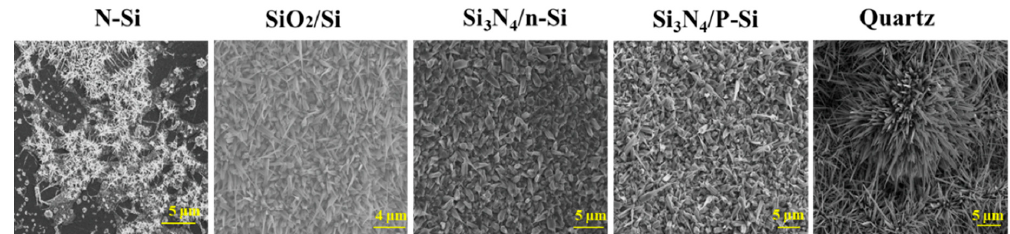
Figure 1. Illustration of the sample set-up inside the furnace, which was used to study the morphology of Ga 2 O 3 on di ff erent substrates. A mixture of liquid Ga as a source and Ag as a catalyst was placed on the surface of substrates to enhance the growth of Ga 2 O 3 .